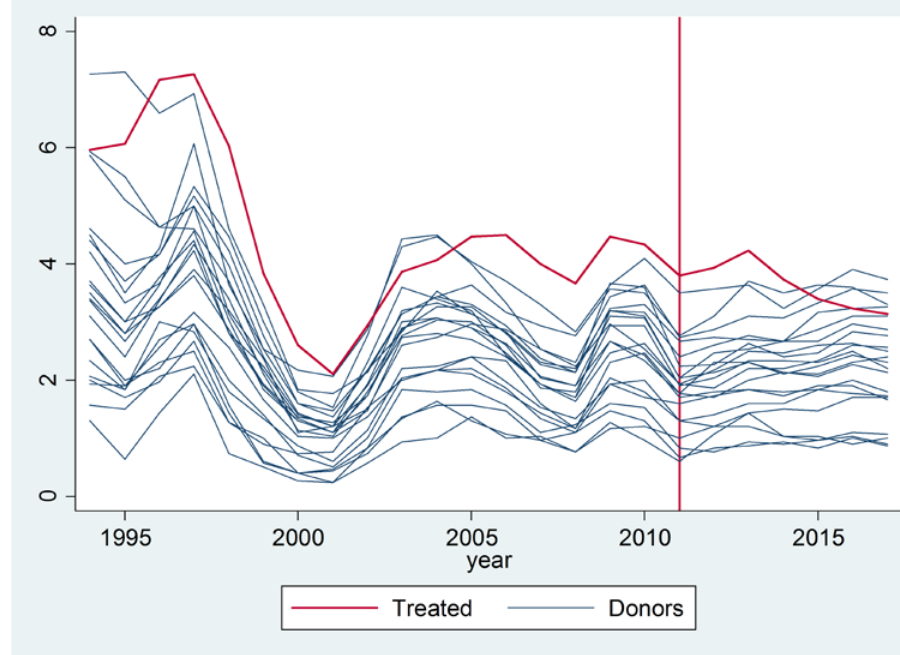
Figure 1. Unemployment rates (SECO) of Ticino (treated) and cantons in the donor